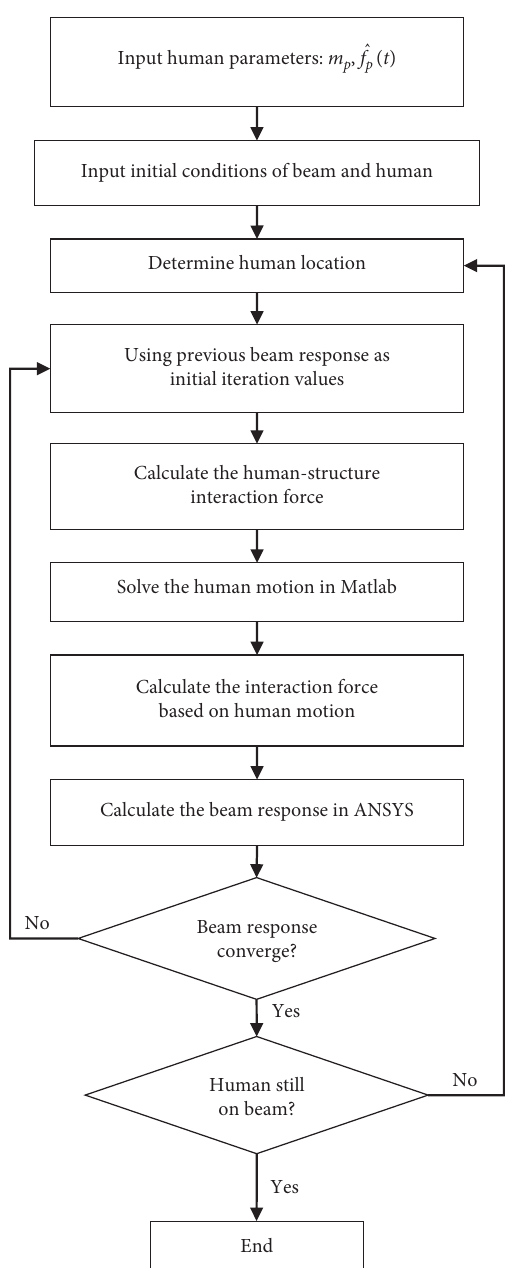
Figure 19: Solution procedure of the bridge-walking human coupled